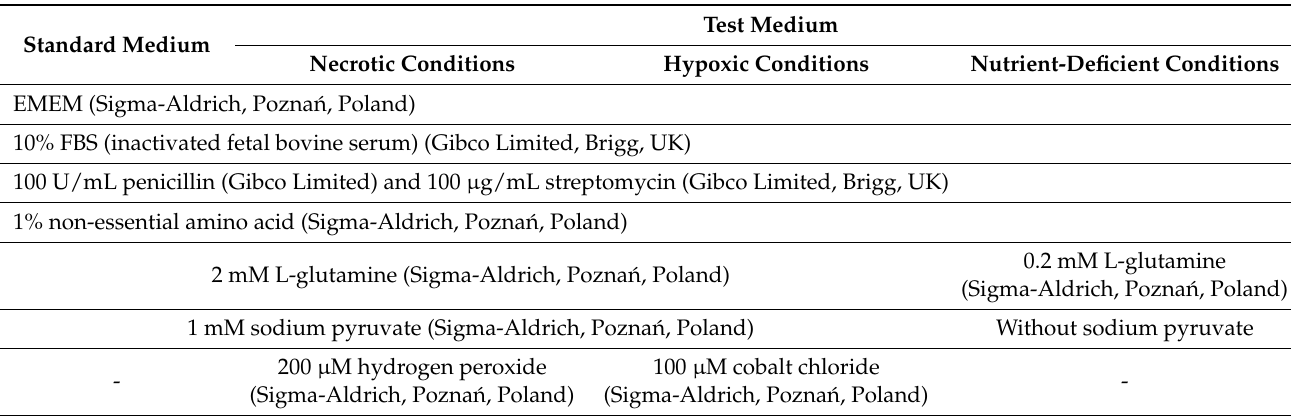
Table 2. Composition of culture media used in the